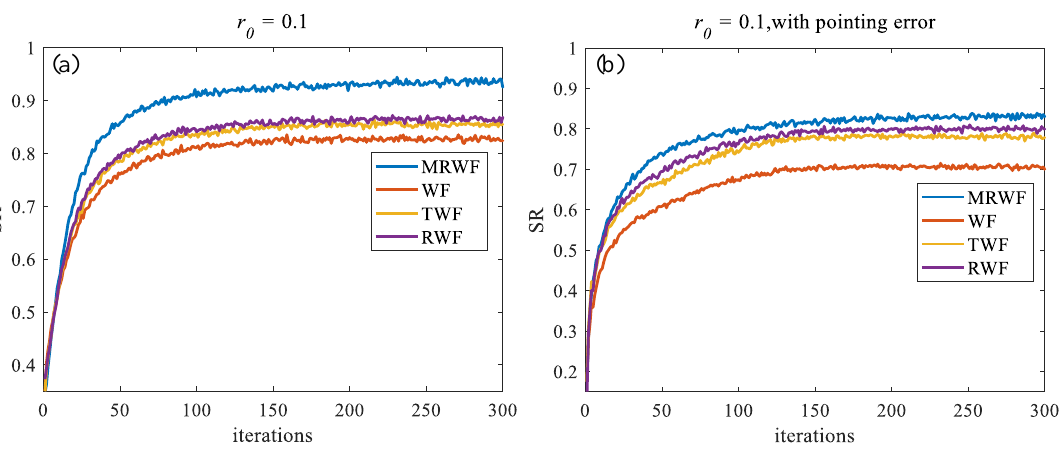
Figure 8. Comparison of SR values after recovery by different algorithms: ( a ) turbulence effect; ( b ) turbulence and pointing error effect.